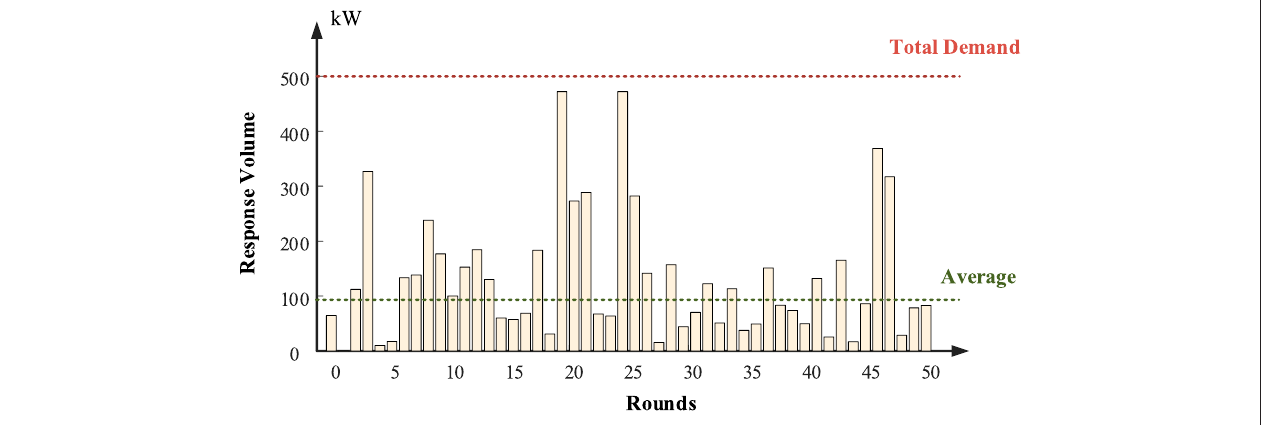
FIGURE 6 | Result distribution of the 50 rounds of operation with 1% information error rate.